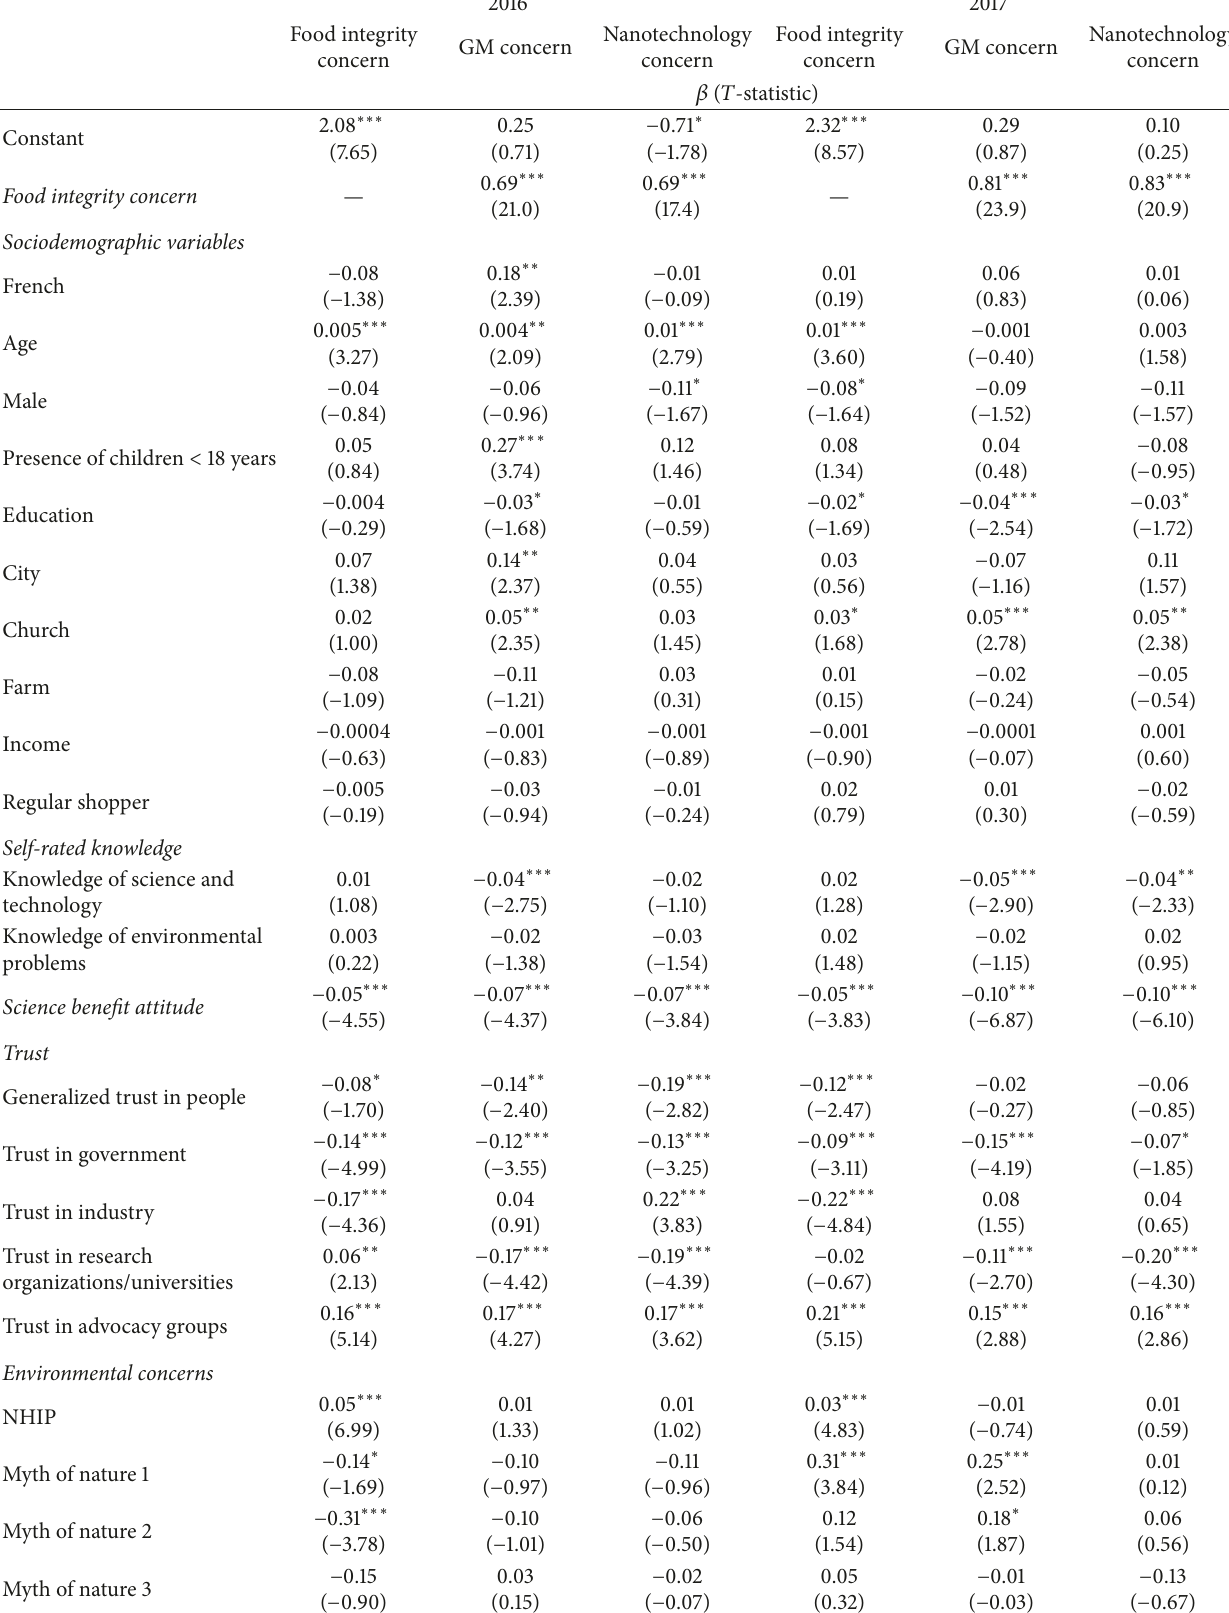
Table 5: Regression results’ concerns about GM and